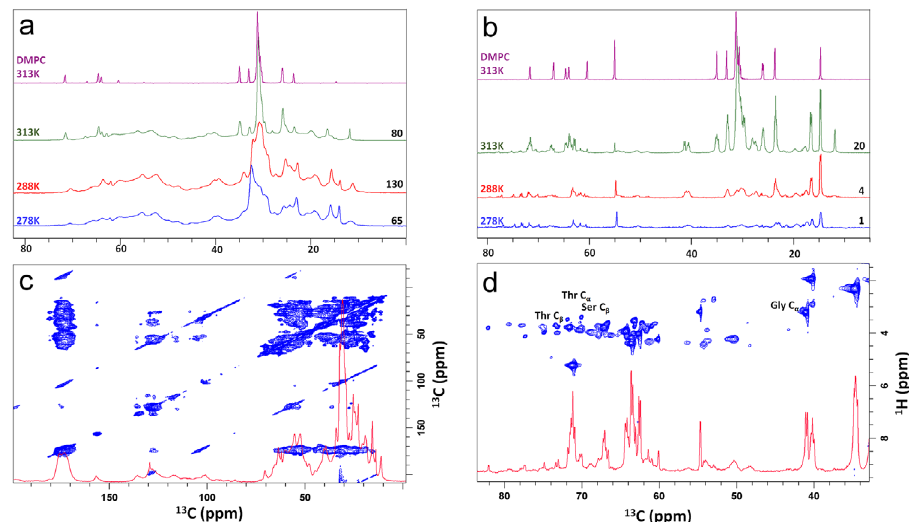
Fig. 3 Solid-state NMR spectra of Bcl-2 proteoliposomes. 13 C CP MAS NMR ( a ) and INEPT MAS NMR spectra ( b ) of U-[ 13 C, 15 N] Bcl-2 reconstituted in DMPC membranes at a 30:1 lipid-to-protein molar ratio with indicated temperatures. Expanded spectral regions are shown between 0 to 80 ppm ( a , b ), 0 to 200 ppm ( c ) and 35 to 80 ppm ( d ). Rigid (low mobility) fractions of the protein and its membrane environment were probed through CP NMR while fl exible regions were detected by INEPT NMR. CP-based 2D 13 C- 13 C correlation DARR (dipolar assisted rotational resonance) spectrum ( c ) with 100 ms mixing time showing signals from the rigid regions of the protein and ( d ) 1 H- 13 C INEPT-based 2D HETCOR (heteronuclear correlation) spectrum of a uniformly 13 C, 15 N-labeled sample showing signals from the protein ’ s fl exible regions. All NMR spectra were acquired at a MAS spinning rate of 15 kHz and 1 H frequency of 850 MHz.